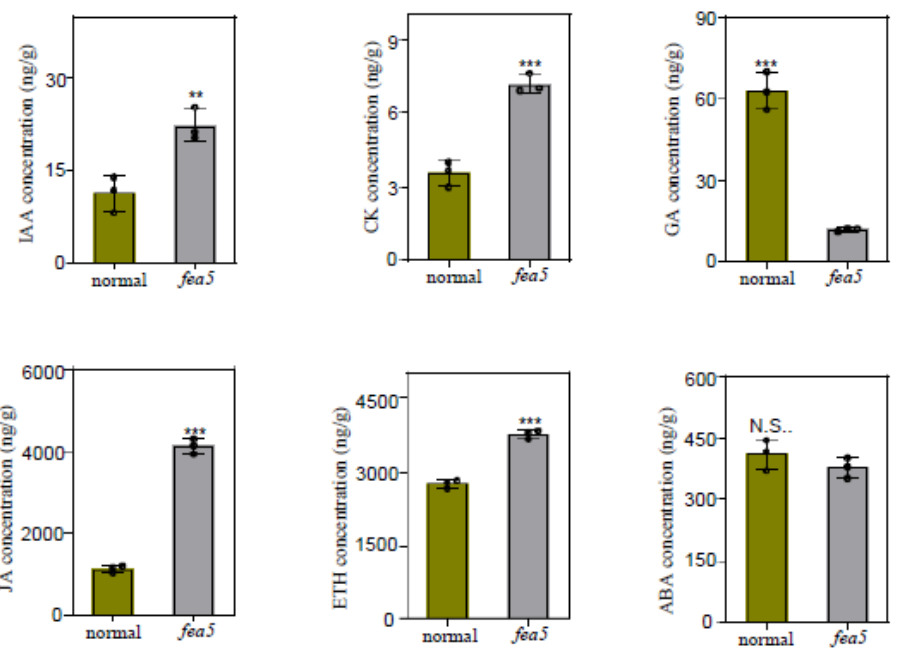
Figure 6. IAA, CK, GA, JA, ETH, and ABA levels in normal and fea5 ears. Student’s t -test was used to compare the means ± SD. Asterisks indicate significant differences: ** p < 0.05 and *** p < 0.01. N.S.: Not significant.